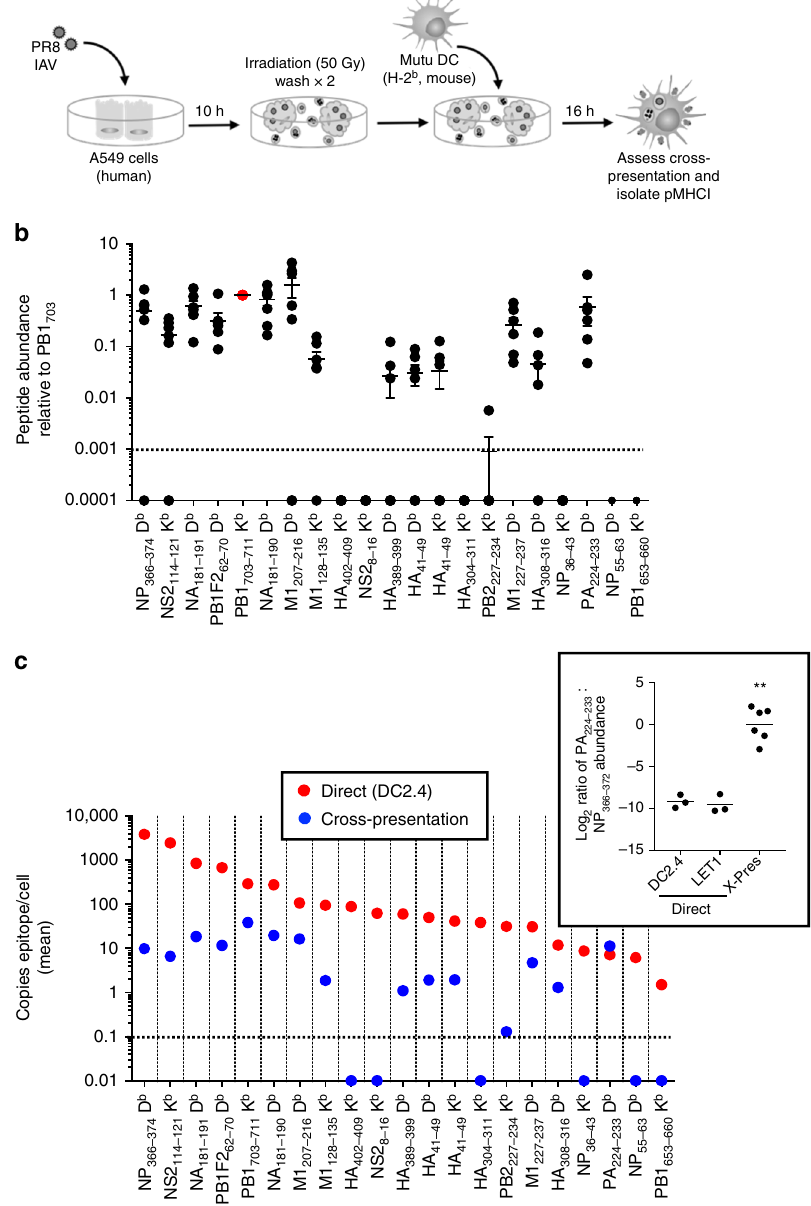
Fig. 3 Detection and quantitation of cross-presented IAV peptides. a Schematic of in vitro cross-presentation work fl ow. A549 cells (5 × 10 7 ) were infected for 10 h with PR8 IAV at an MOI of 10. The A549 cells were then γ -irradiated (50 Gy) and co-incubated for 16 h with 5 × 10 7 Mutu DCs. Epitopes were then eluted from immunoaf fi nity-puri fi ed K b and D b MHCI molecules and analyzed by LC-MRM. b Shown is the mean relative abundance ± SEM of each peptide compared to PB1 703 – 711 (in red) within the same experiment. c Absolute quantitation (mean epitope copies/cell shown) of peptide abundance following direct infection and cross-presentation. Direct epitope abundance shown in red circles while cross-presented epitope abundance shown in blue circles. Inset shows the ratio of log 2 transformed PA 224 – 233 : NP 366 – 374 epitope abundance for each of the different analyses of epitope presentation. N = 7 independent cross-presentation assays. ** p < 0.0001 comparing cross-presentation and direct (DC2.4) ratios, and cross-presentation and direct (LET1) ratios, using one-way ANOVA with Tukey post-hoc